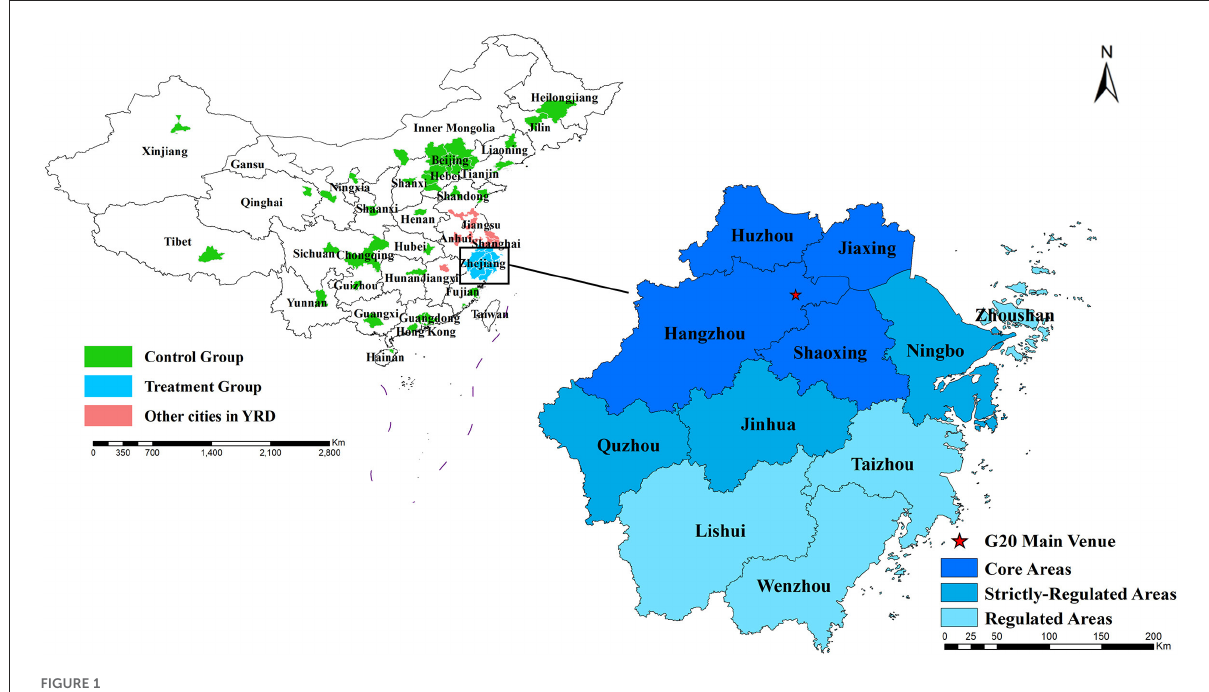
FIGURE1 The distribution of 60 cities involved in this study.